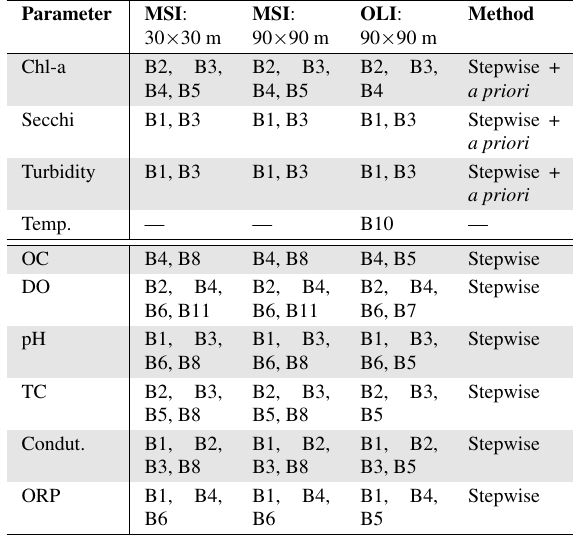
Table 4. Selection of spectral bands and method